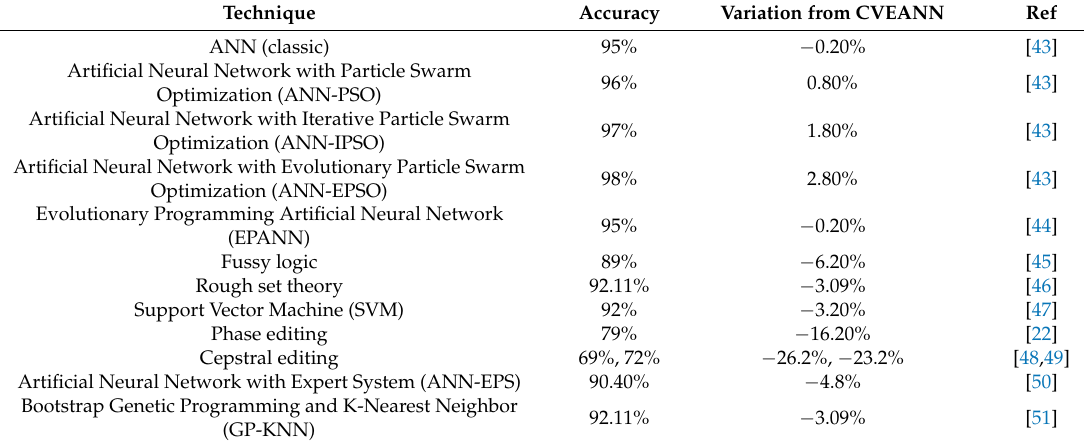
Table 5. Comparison of the performance of different fault detection and identification techniques with Cross-Validation Ensemble ANN